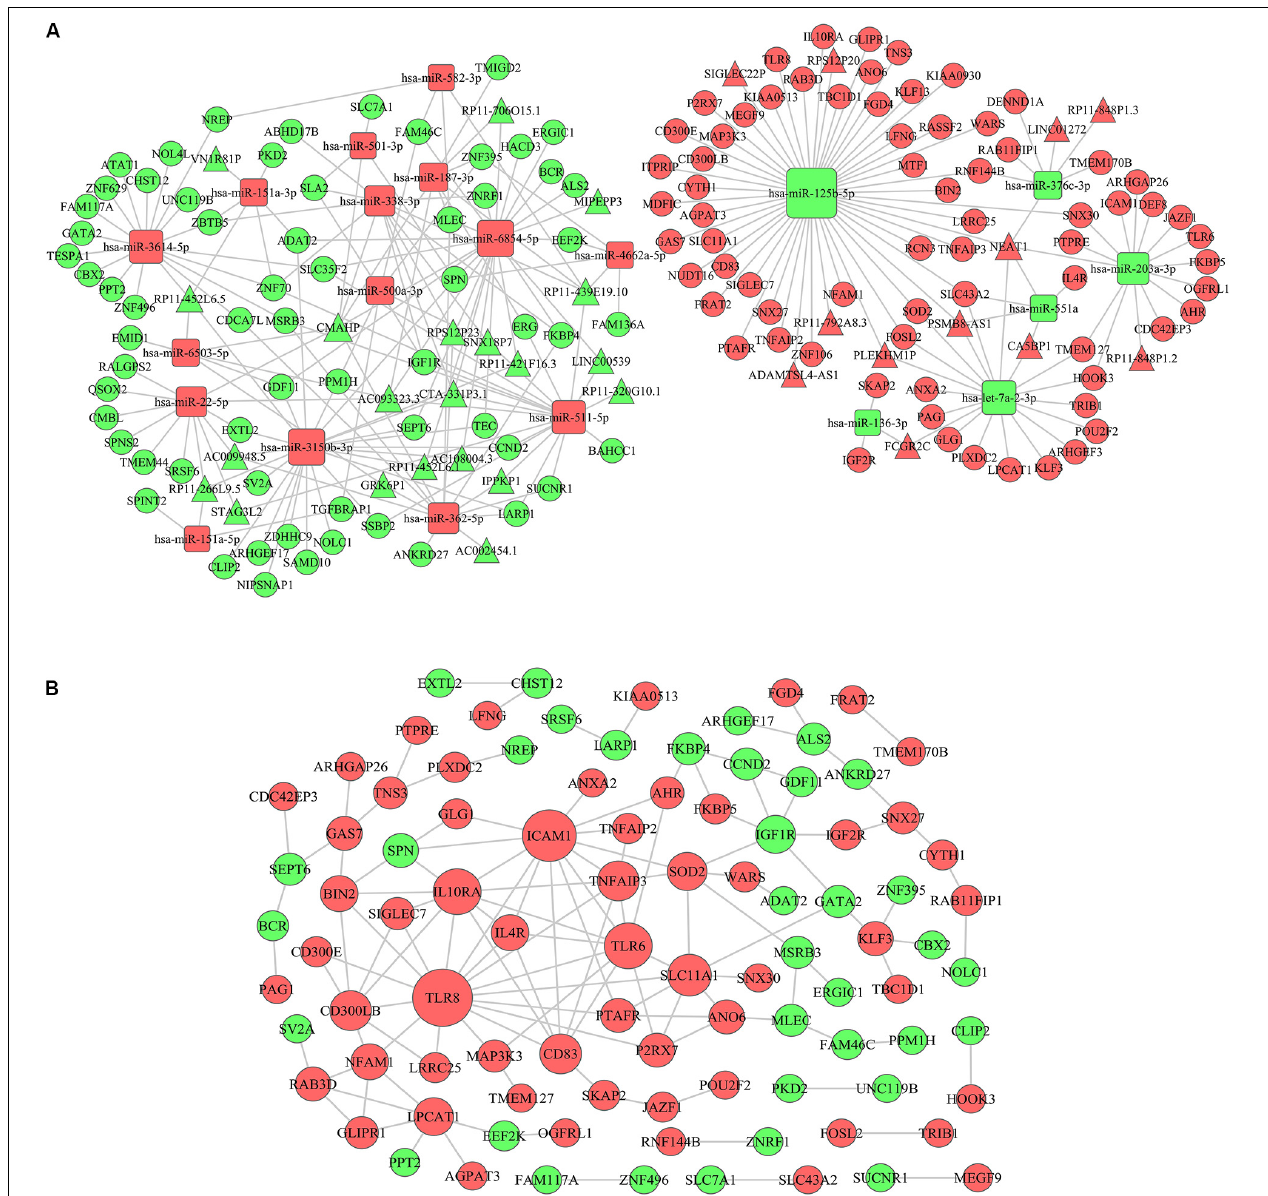
FIGURE 6 | ceRNA network construction and protein–protein interaction network. (A) A lncRNA-miRNA-mRNA ceRNA network was constructed by 33 lncRNAs, 21 miRNAs, and 135 mRNAs. (B) A PPI network was constructed based on the STRING database. The rectangle represents microRNAs, the circle represents mRNAs and the triangle represents lncRNAs; the red represents up-regulation in IS-high and the green represents down-regulation in IS-high; the size of the dot represents the regulatory capacity of the mRNA, and larger points indicate stronger regulatory capability. ceRNA, competing endogenous RNAs; PPI: protein–protein